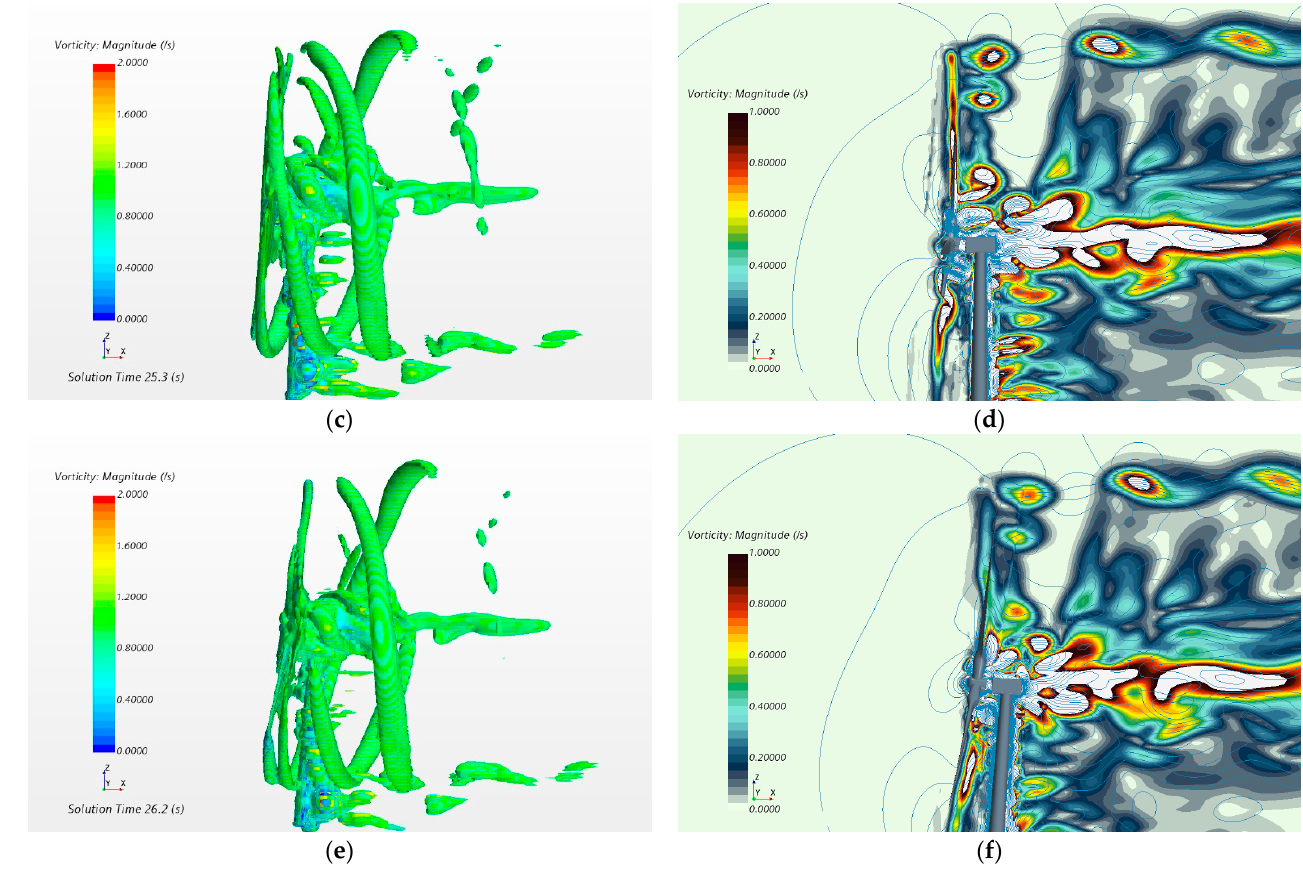
Figure 16. Wake scheme under same-phase combined motion. ( a ) Iso-surface at T0 moment under case 14; ( b ) velocity in the symmetry plane at T0 moment under case 14; ( c ) iso-surface at T0 moment under case 16; ( d ) velocity in the symmetry plane at T0 moment under case 16; ( e ) iso-surface at T2 moment under case 16; ( f ) velocity in the symmetry plane at T2 moment under case 16.